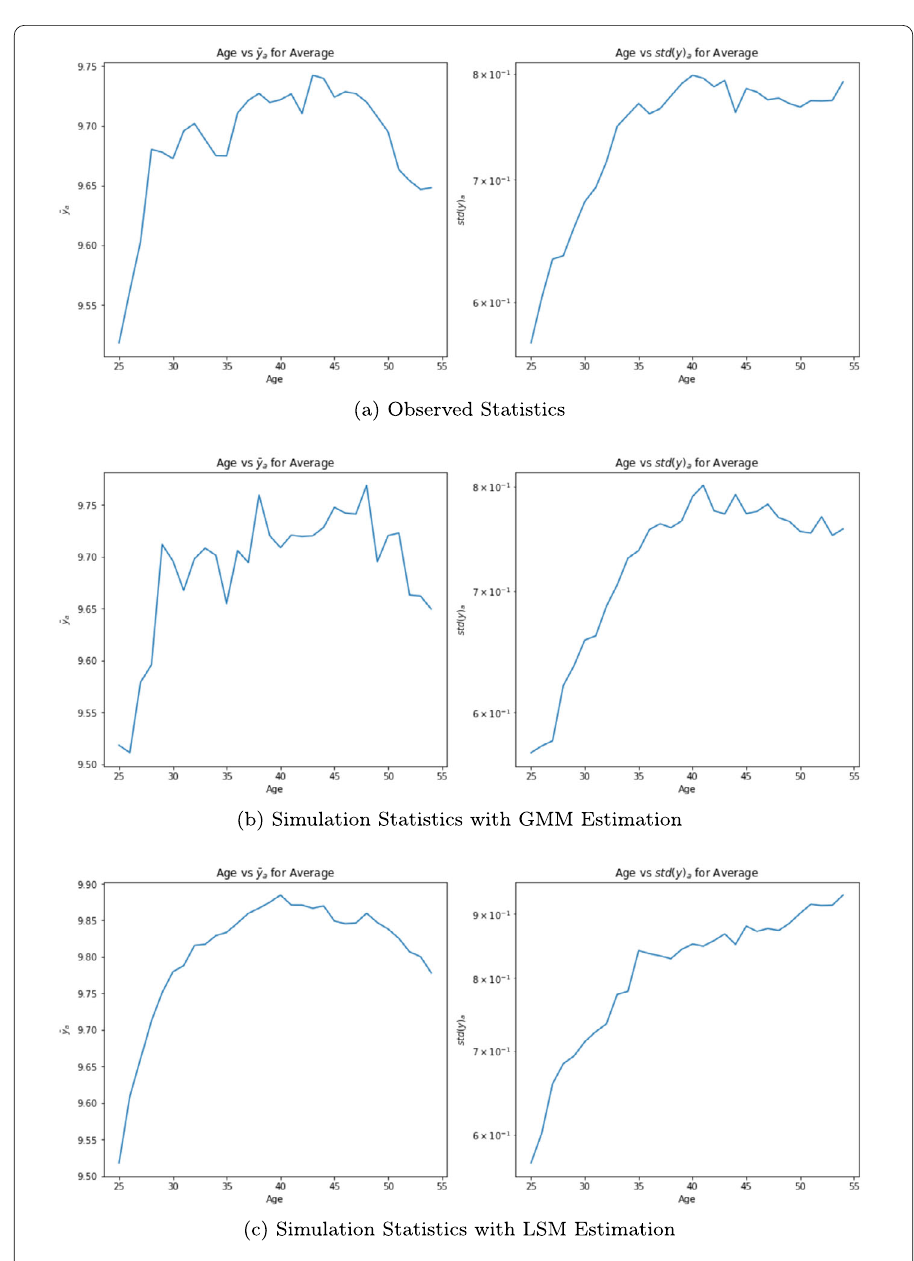
Figure 6 UK Labour Data Observed and Simulation Statistics representing average and standard deviation of the survey data and simulated population, which reflect similar shape with the statistics from survey